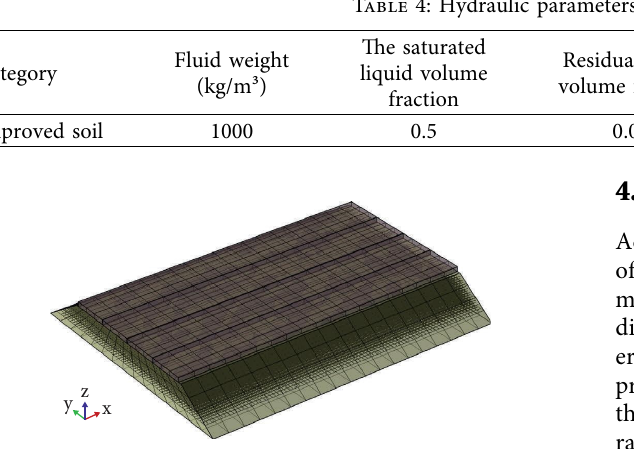
Figure 5: Model meshing generation diagram.